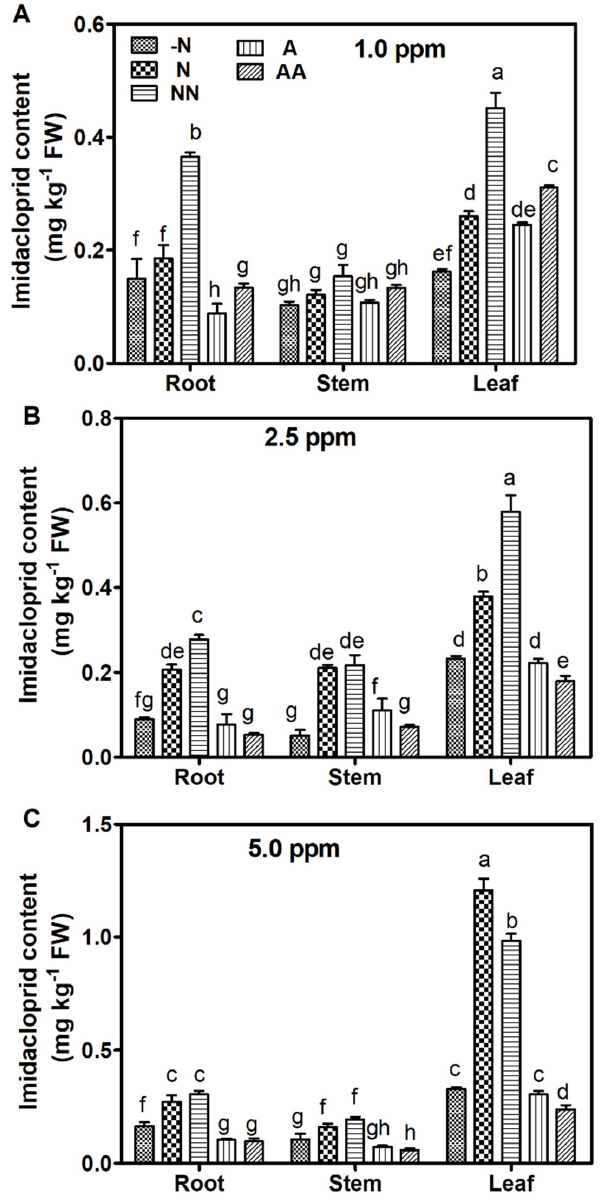
Figure 2. The content of IMI in maize tissues. The seedlings were grown in modified Hoagland nutrient solution ( − N: no nitrogen supply, N: 4 mmol L − 1 NO 3 − , NN: 10 mmol L − 1 NO 3 − , A: 4 mmol L − 1 NH 4+ and AA: 10 mmol L − 1 NH 4+ ), containing 1 (A), 2.5 (B) or 5 ppm (C) IMI, for 14 days. The different letters indicate the differences in p -value < 0.05 by LSD test.